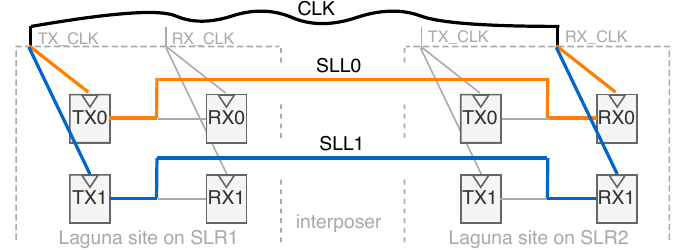
Figure 8: Schematic of a PUF unit cell, and its differential delay paths using two SLLs.